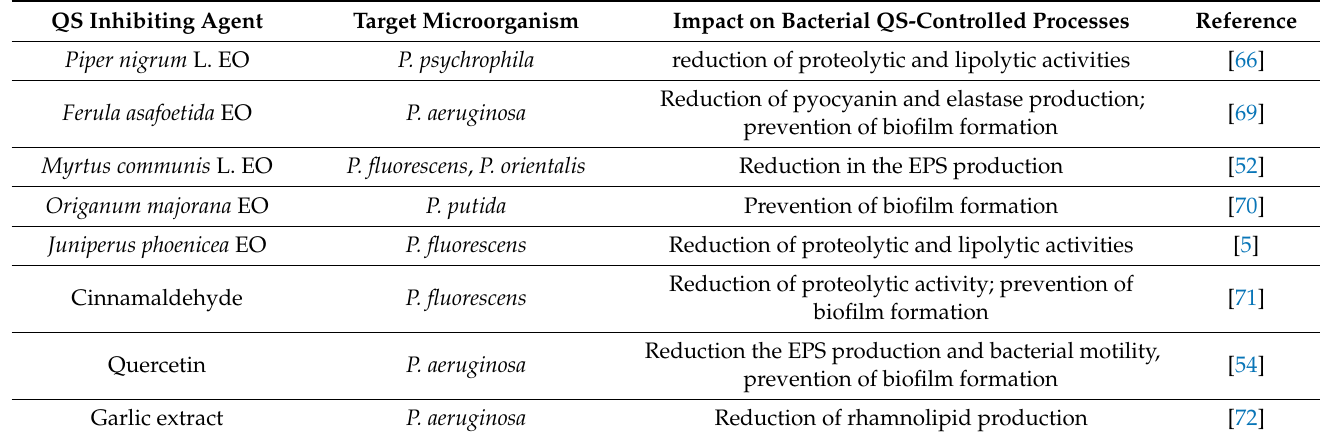
Table 2. Impact of natural QS inhibiting agents on fish-associated Pseudomonas